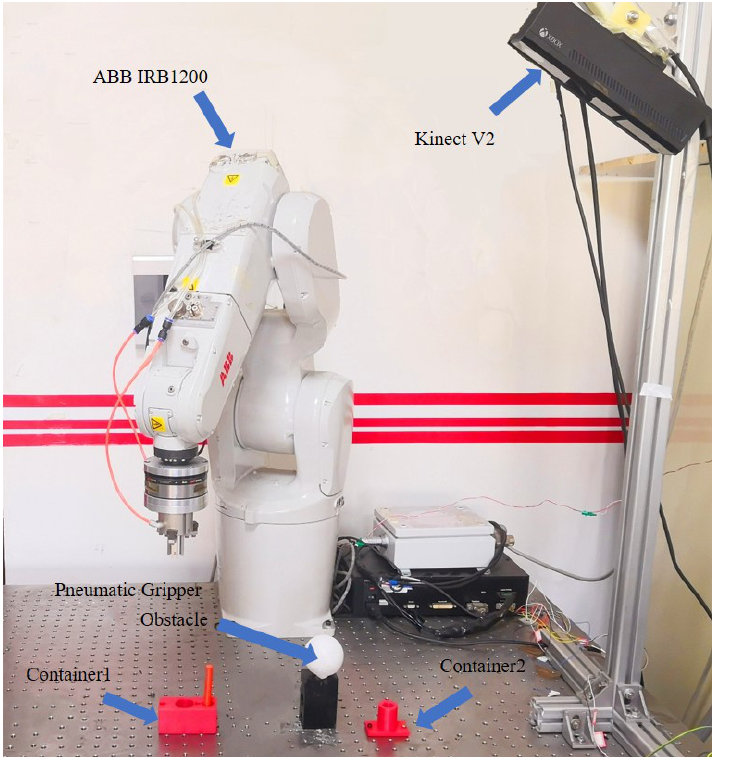
Figure 8. The experimental platform.